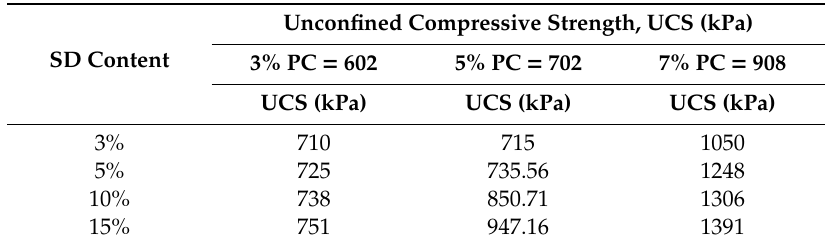
Table 6. UCS results before sulphate exposure in presence of SD (7 days curing).